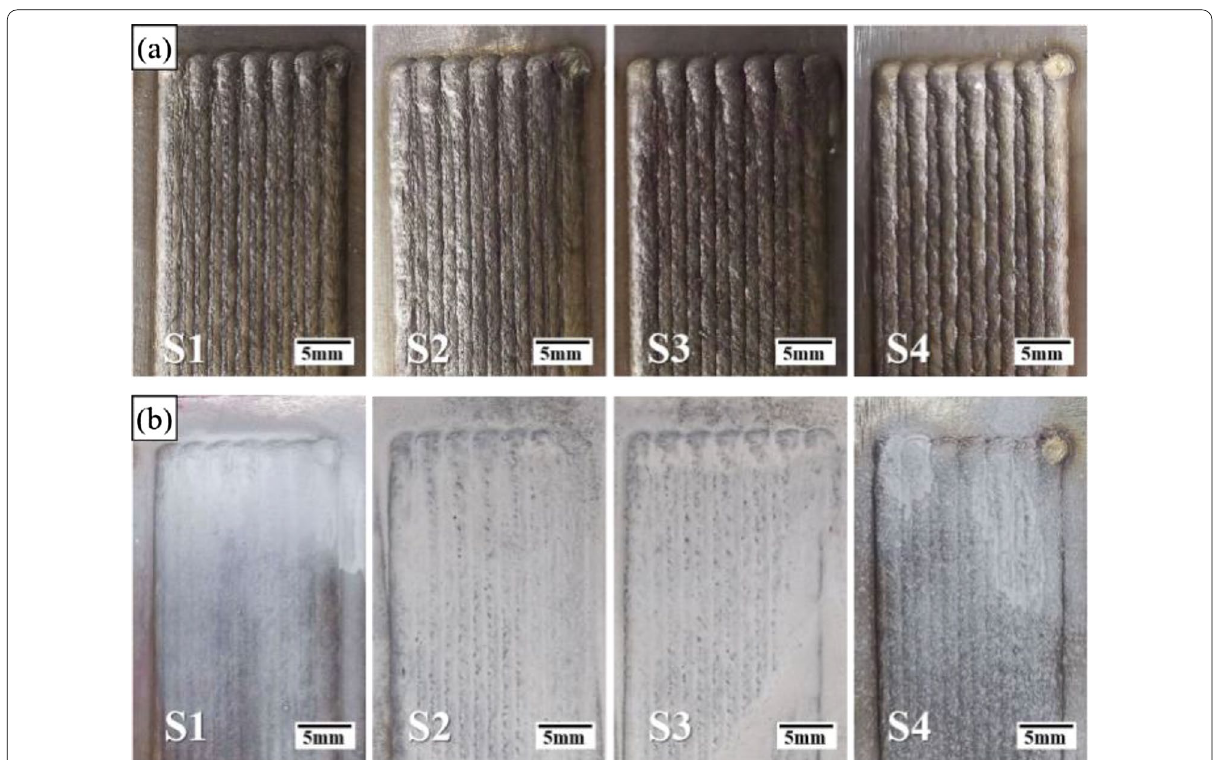
Figure 4 Top morphologies of cladding surfaces: a depositing surface and b HD-ST surface permeated by DPT-5 dyeing